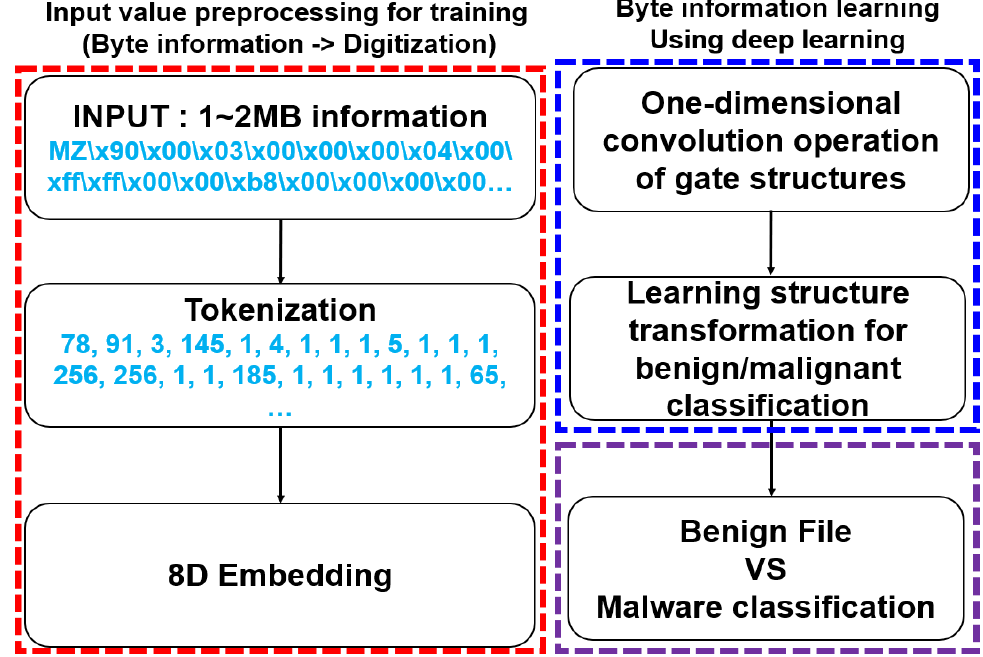
Figure 7. DL-based malware classification model architecture.